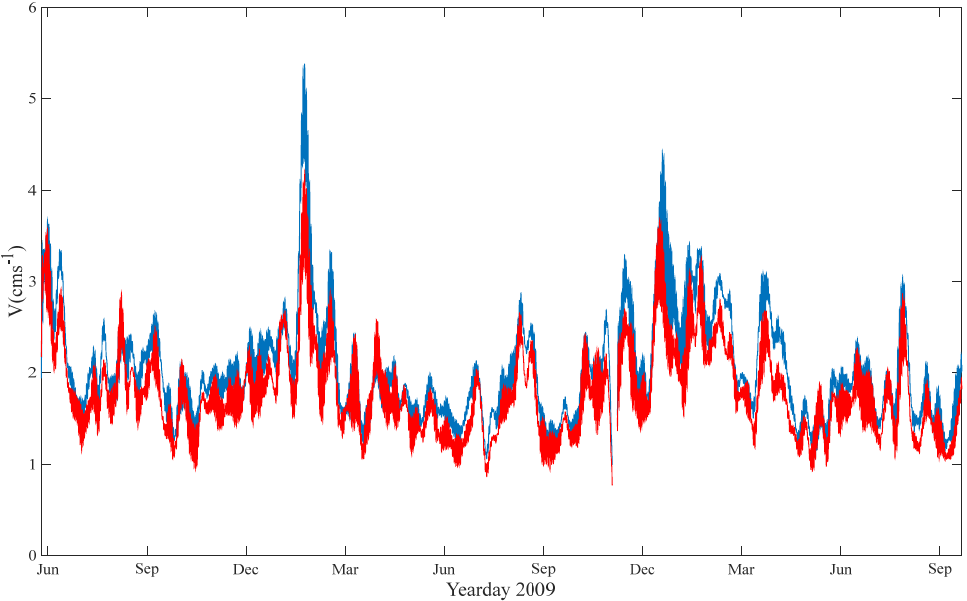
Figure 5. Depth-averaged velocity amplitudes of raw near-inertial current (blue) and WKB-scaled current (red).